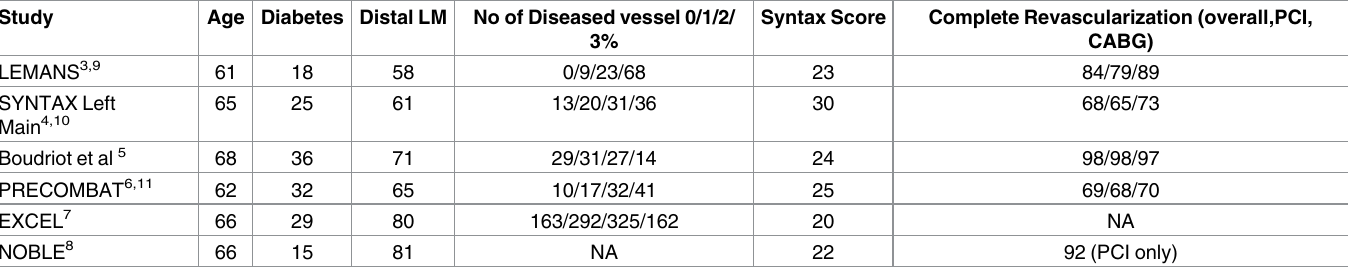
Table 2. Patients and procedural features of included